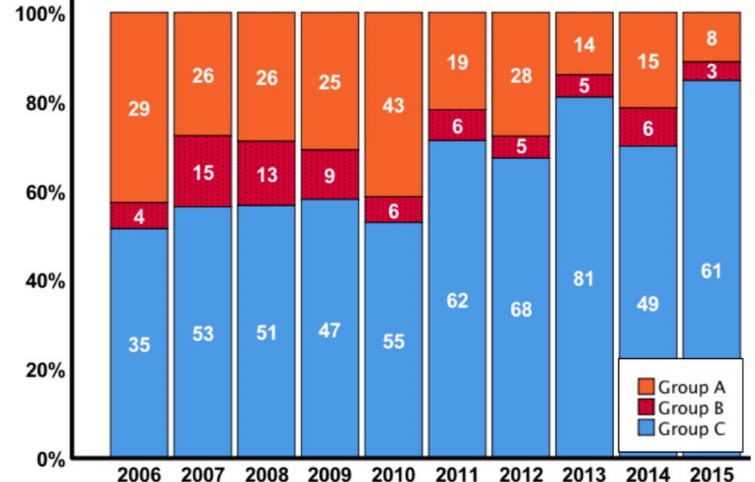
Figure 2. Proportion and absolute numbers of lymphocele formation, intervention and control by year. * Group A = lymphocele conservatively monitored; Group B = lymphocele with intervention; Group C =